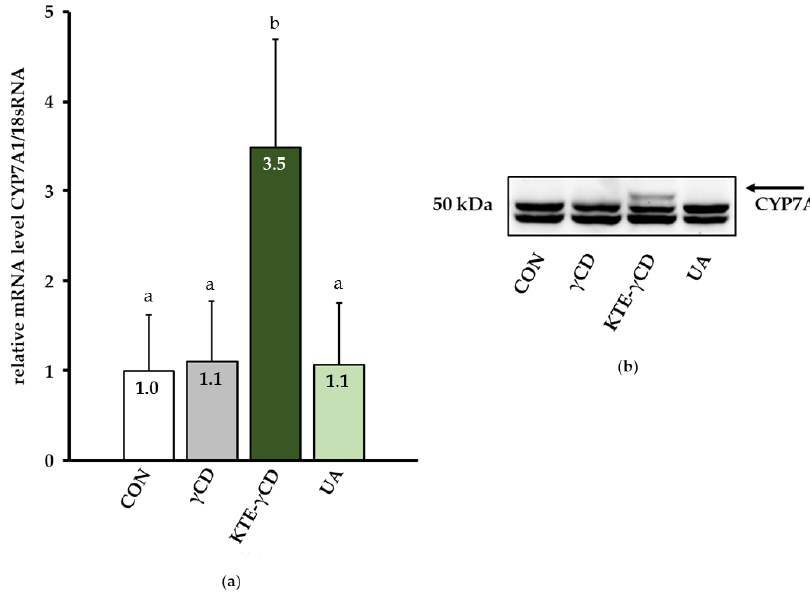
Figure 5. Kuding tea extract-γ-cyclodextrin (KTE-γCD) increased the mRNA ( a ) and protein ( b ) levels of cytochrome P450, family 7, subfamily a, polypeptide 1 (CYP7A1) compared to the other groups